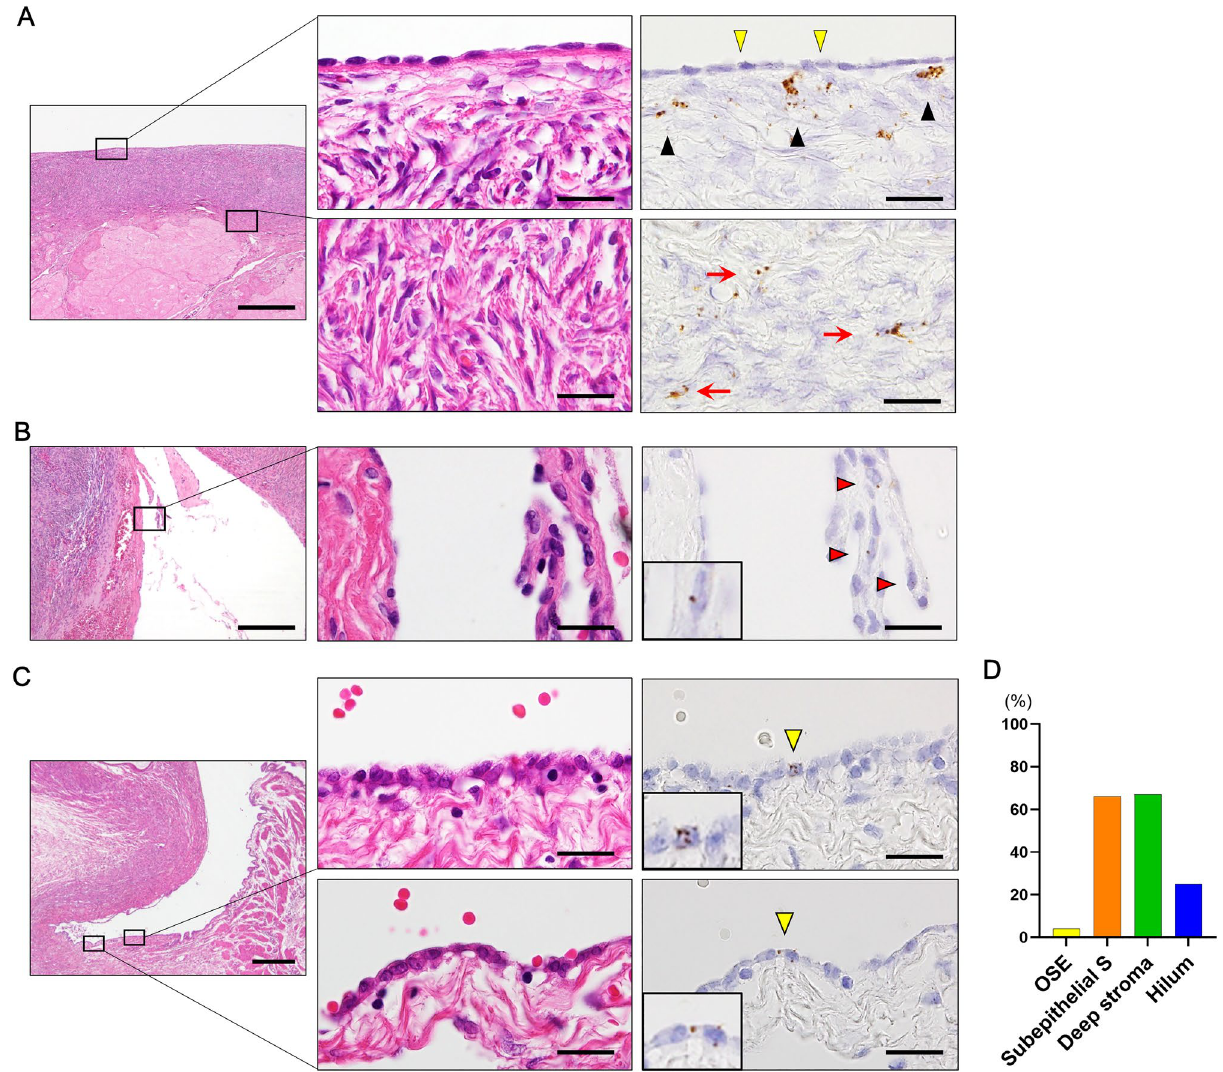
Figure 1. LGR5 expression in normal ovary surface epithelium and stromal cells. ( A ) LGR5 expression is not observed in the ovary surface epithelium (OSE) (indicated by yellow arrowheads), while subepithelial stromal cells often exhibit LGR5 expression (indicated by black arrowheads). Sparse LGR5 -positive stromal cells are observed in the deep ovarian stroma (indicated by red arrows). Scale bar, 0.5 mm (left panel) and 20 µm (middle and right panels). ( B ) Only one ovary displayed LGR5 -positive surface epithelial cells, which appeared among proliferating epithelial cells near the hemorrhagic area (indicated by red arrowheads, magnified image shown in the inset). Scale bar, 0.5 mm (left panel) and 20 µm (middle and right panels). ( C ) LGR5 -positive cells are rarely observed in the ovarian hilum (indicated by yellow arrowheads, magnified image shown in the insets). Scale bar, 0.5 mm (left panel) and 20 µm (middle and right panels). ( D ) A bar graph showing the percentage of cases in which LGR5 expression was observed in each area of the ovary (OSE, n = 23, subepithelial S, n = 23, deep stroma, n = 29, hilum, n = 4). Subepithelial S Subepithelial